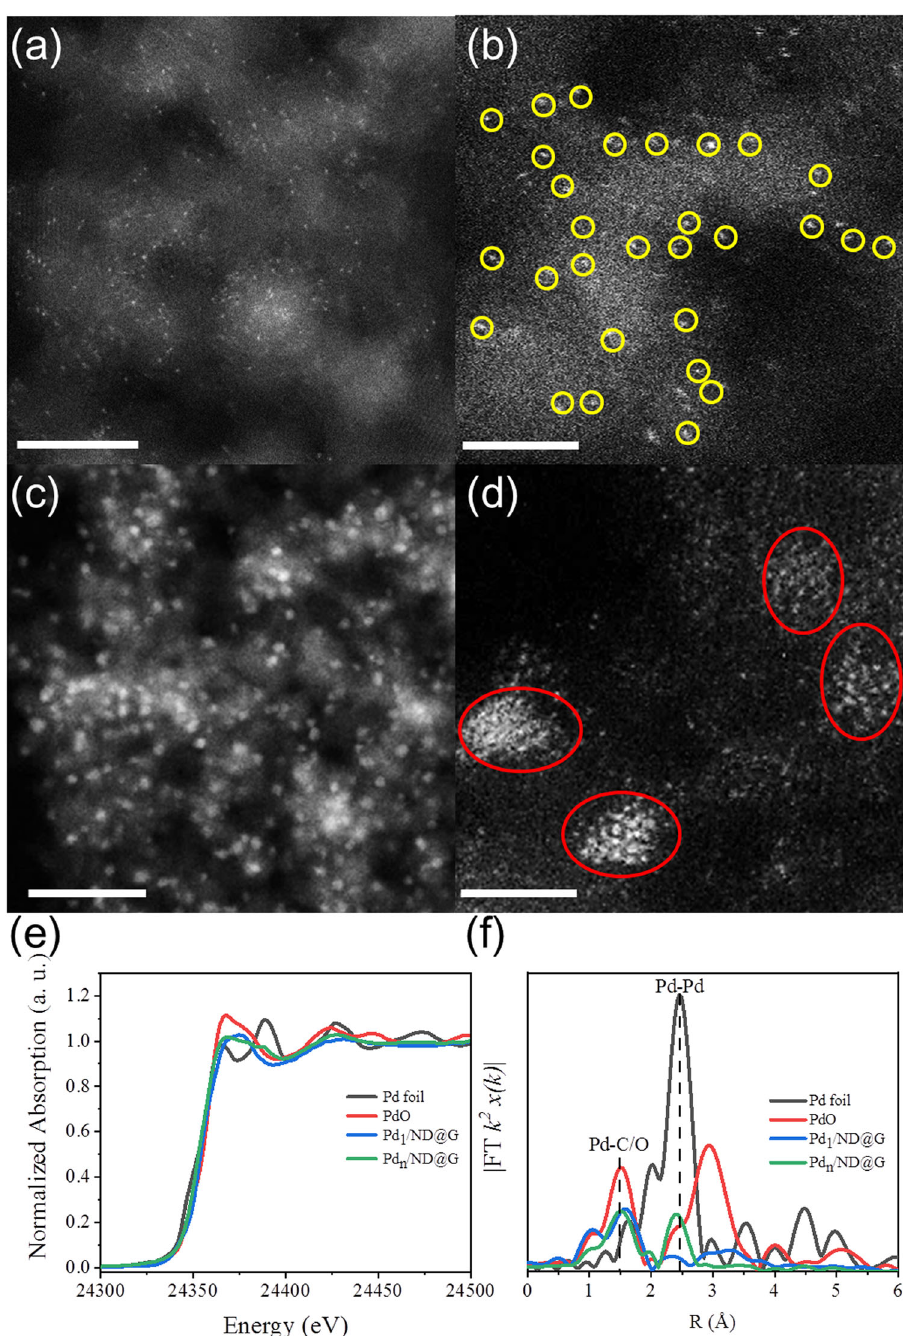
Fig. 1 Structural characterization of catalysts. a HAADF-STEM images of Pd 1 /ND@G at low magni fi cation. b Atomically dispersed single Pd atoms in Pd 1 /ND@G highlighted by the yellow circles. c HAADF-STEM images of Pd n /ND@G at low magni fi cation. d Fully exposed Pd clusters in Pd n /ND@G highlighted by the red circles. e Pd K-edge XANES pro fi les and f EXAFS spectra for Pd 1 /ND@G and Pd n /ND@G. Scale bars: a , 5 nm; b , d , 2 nm; c , 20